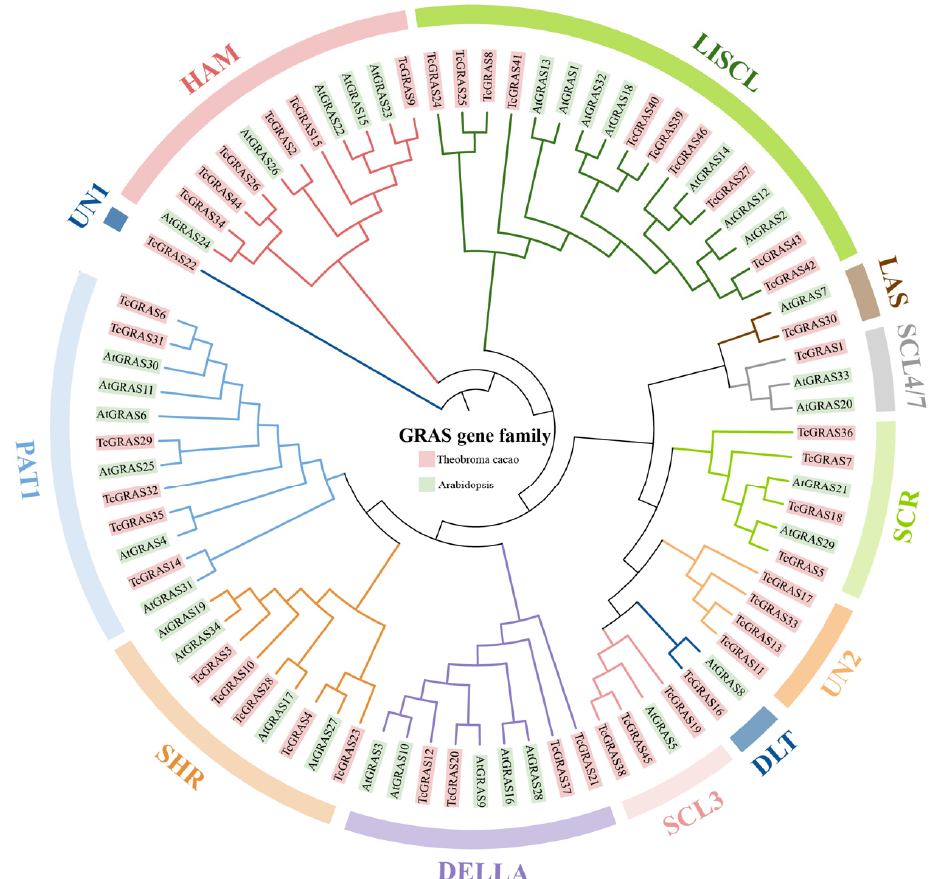
Figure 1. Phylogenetic tree of GRAS genes in T. cacao and A. thaliana . The GRAS genes in T. cacao and A. thaliana are shown in red and green, respectively. The tree branched the GRAS proteins into different subgroups, illustrated by different colored clusters within the clade. TcGRAS are divided into twelve subgroups according to the subgrouping of A. thaliana . The phylogenetic tree was constructed using the maximum likelihood (ML) method with 1000 bootstrap replications of the MEGA 11 software.